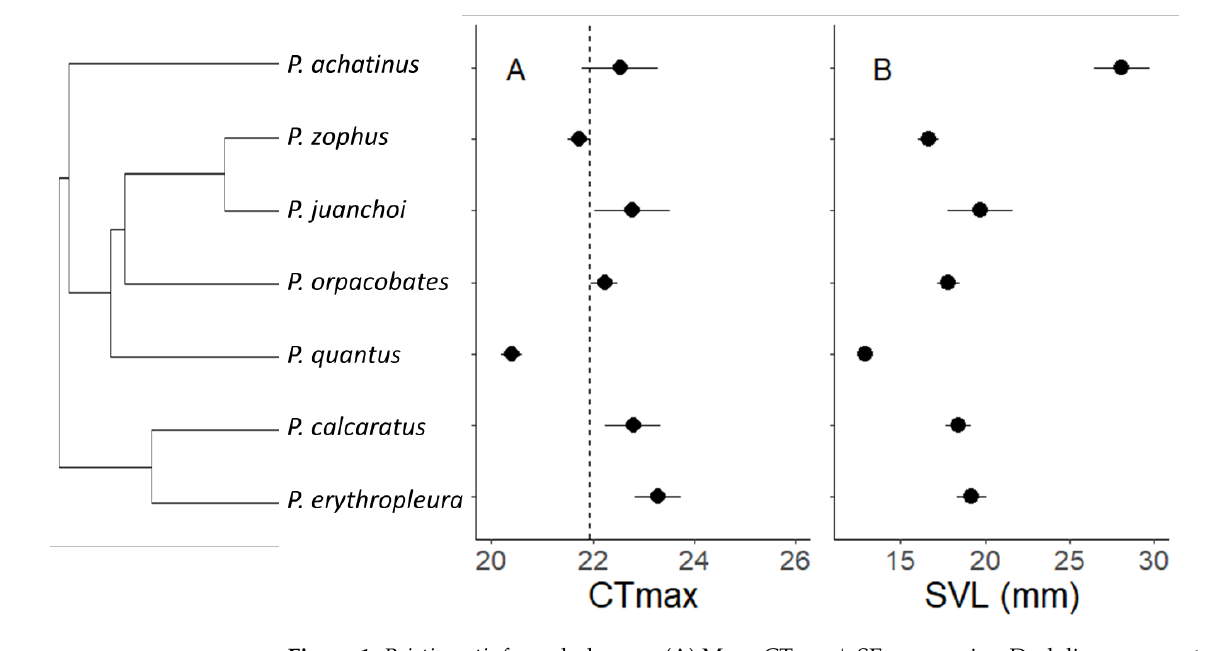
Figure 1. Pristimantis frog phylogeny. ( A ) Mean CT max ± SE per species. Dash line represents mean CT max across all seven species. ( B ) Mean SVL ± SE per species.